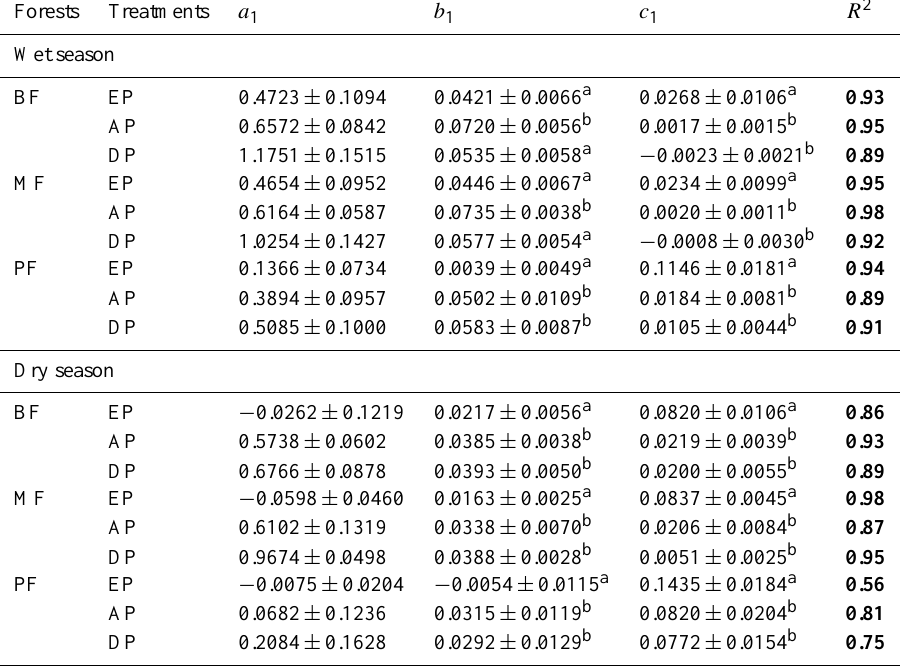
Table 4. Relationships of soil respiration ( R , µmolCO 2 m − 2 s − 1 ) with soil temperature ( T , ◦ C) and soil moisture ( M , %vol.) using a combined exponential and linear function ( R = (a 1 + c 1 M) exp (b 1 T ) , where a 1 is parameter related to basal soil respiration when both T = 0 and M = 0; b 1 and c 1 are parameters related to the temperature and moisture sensitivities of soil respiration, respectively) under different seasons and precipitation treatments at the DNR forests (parameter estimate ± standard error). The treatments are as follows: precipitation exclusion (EP), ambient precipitation (AP), and double precipitation (DP). The forests are as follows: broadleaf forest (BF), mixed forest (MF), and pine forest (PF). R 2 is the coefficient of determination. Numbers in bold indicate the level of function fitting is significant ( p < 0 . 05). Different superscripted letters in each forest site within a column denote significant difference ( p < 0 . 05) among precipitation